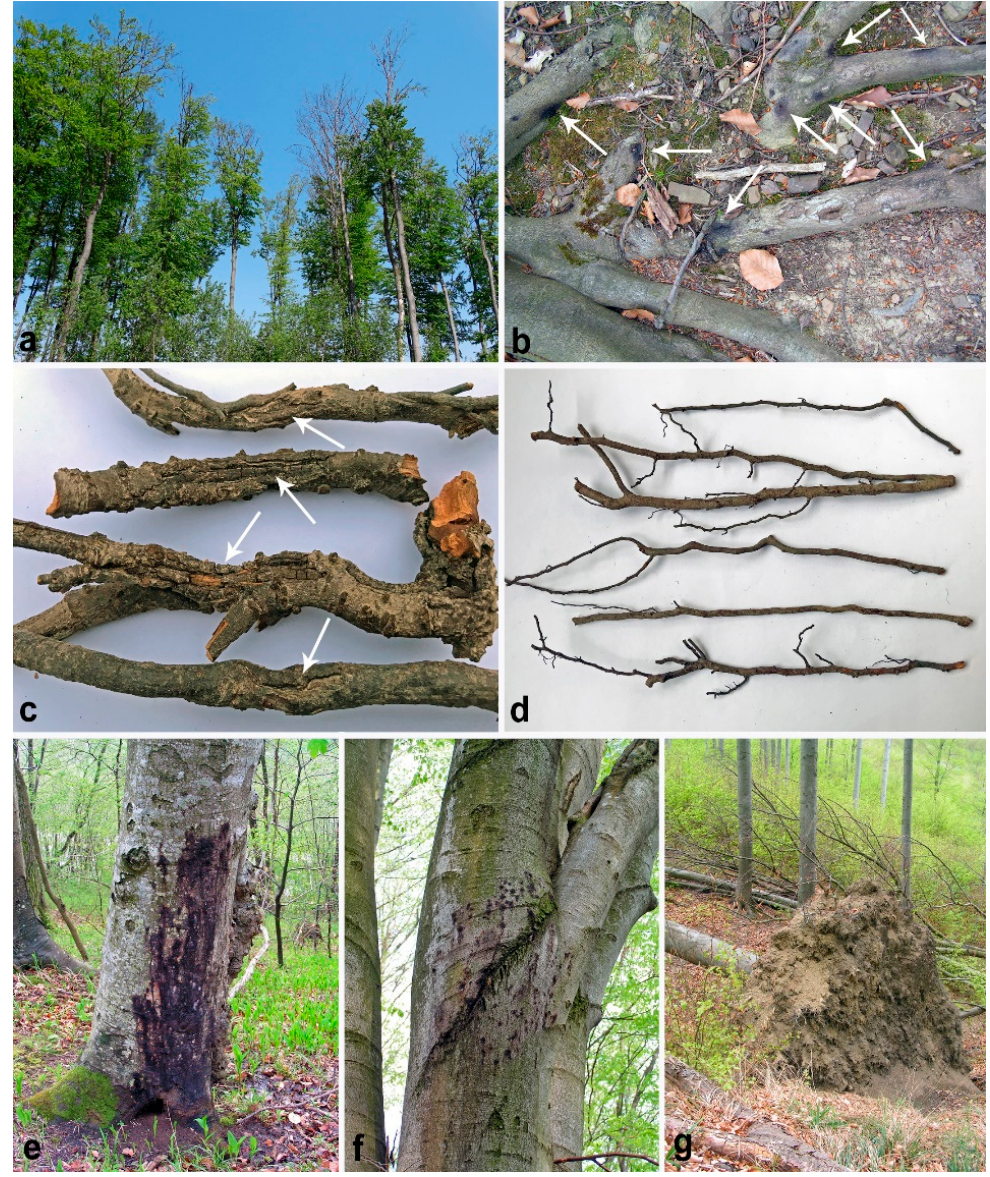
Figure 2. Decline and dieback symptoms caused by Phytophthora spp. on Fagus sylvatica in Lower Austria; ( a ) severe dieback, chlorosis and mortality due to root and collar rot caused by Phytophthora × cambivora in stand F01 Hadersfeld 1; ( b ) bleeding bark lesions caused by P . × cambivora on surface roots in stand F16 Hengstlberg; ( c ) coarse roots of wind-thrown beech trees in stand F16 Hengstlberg, with severe losses of lateral roots and open callusing lesions caused by P . × cambivora ; ( d ) small woody roots with extensive losses of lateral roots and fine roots caused by P. plurivora and P. syringae in stand F03 Kaisersteinbruch; ( e ) bleeding collar rot lesion caused by P . × cambivora in stand F34 Wienerwaldsee; ( f ) aerial bleeding canker caused by P . plurivora in stand F19 Hohenegg 2; ( g ) wind-thrown beech trees in stand F16 Hengstlberg due to severe root losses and root lesions caused by P . × cambivora .